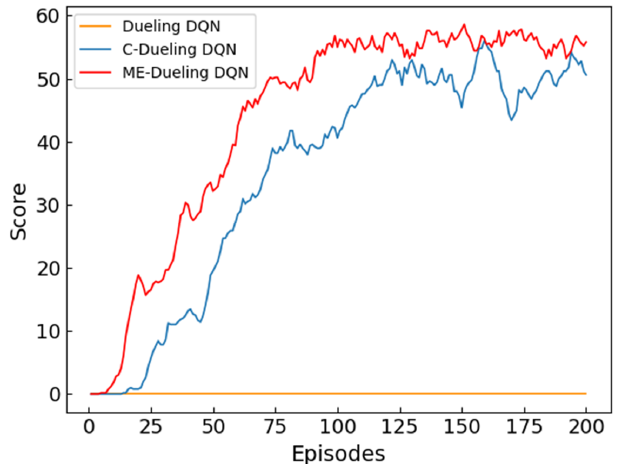
Figure 7. The score change process of each algorithm.